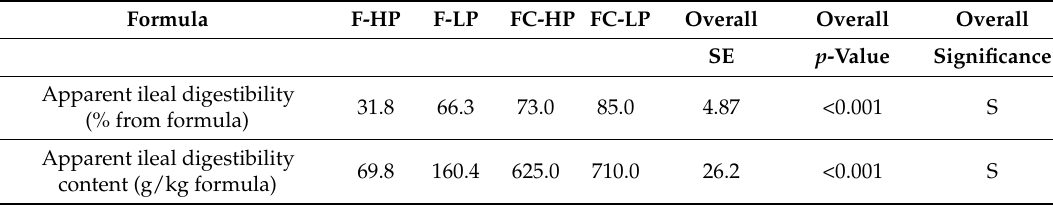
Table 3. Apparent ileal digestibility and ileal digestibility content.